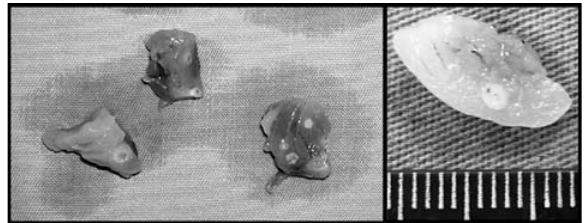
Figura 2 – Linfonodos destacados como pequenos nódulos brancos na gordura pericólica após processo de